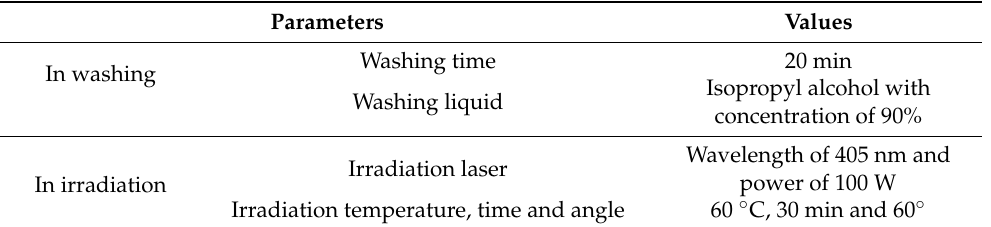
Table 2. The uniform parameters in the post-processing in this research.